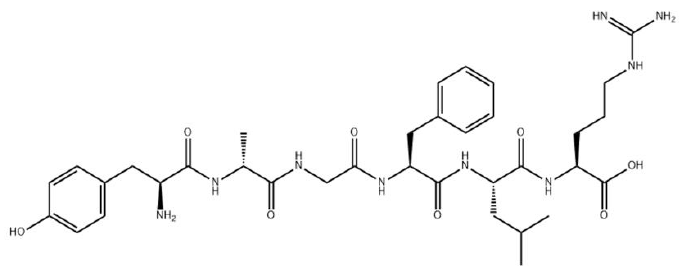
Figure 5. Chemical structure of dalargin.